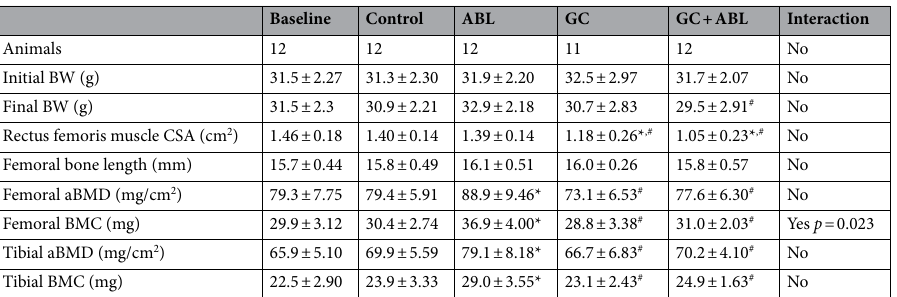
Table 1. Number of animals, initial and final bodyweight (BW), rectus femoris cross-sectional area (CSA), femoral bone length, aBMD (areal bone mineral density), and BMC (bone mineral content) of mice subjected to subcutaneous slow-release glucocorticoid (GC) pellets and treated with abaloparatide (ABL) for four weeks. Mean ± SD. * p < 0.05 vs. Control. # p < 0.05 vs. ABL.